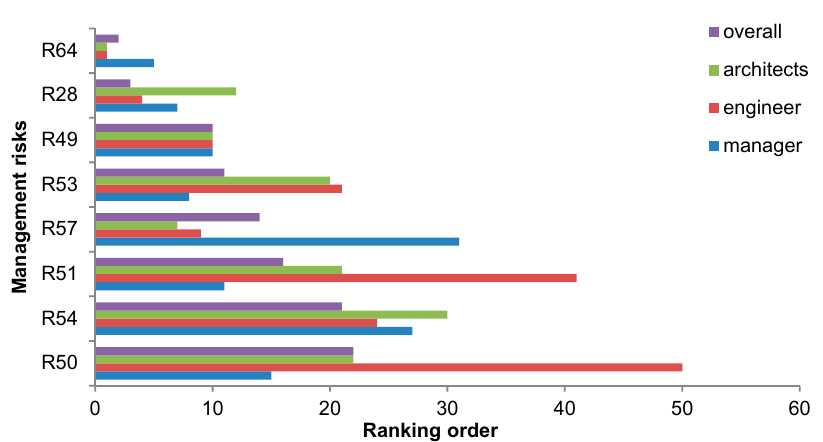
Figure 8. Ranking the management risk factors impacting on the project value. All respondents agree on considering R28 and R49 risks during the appraisal of green